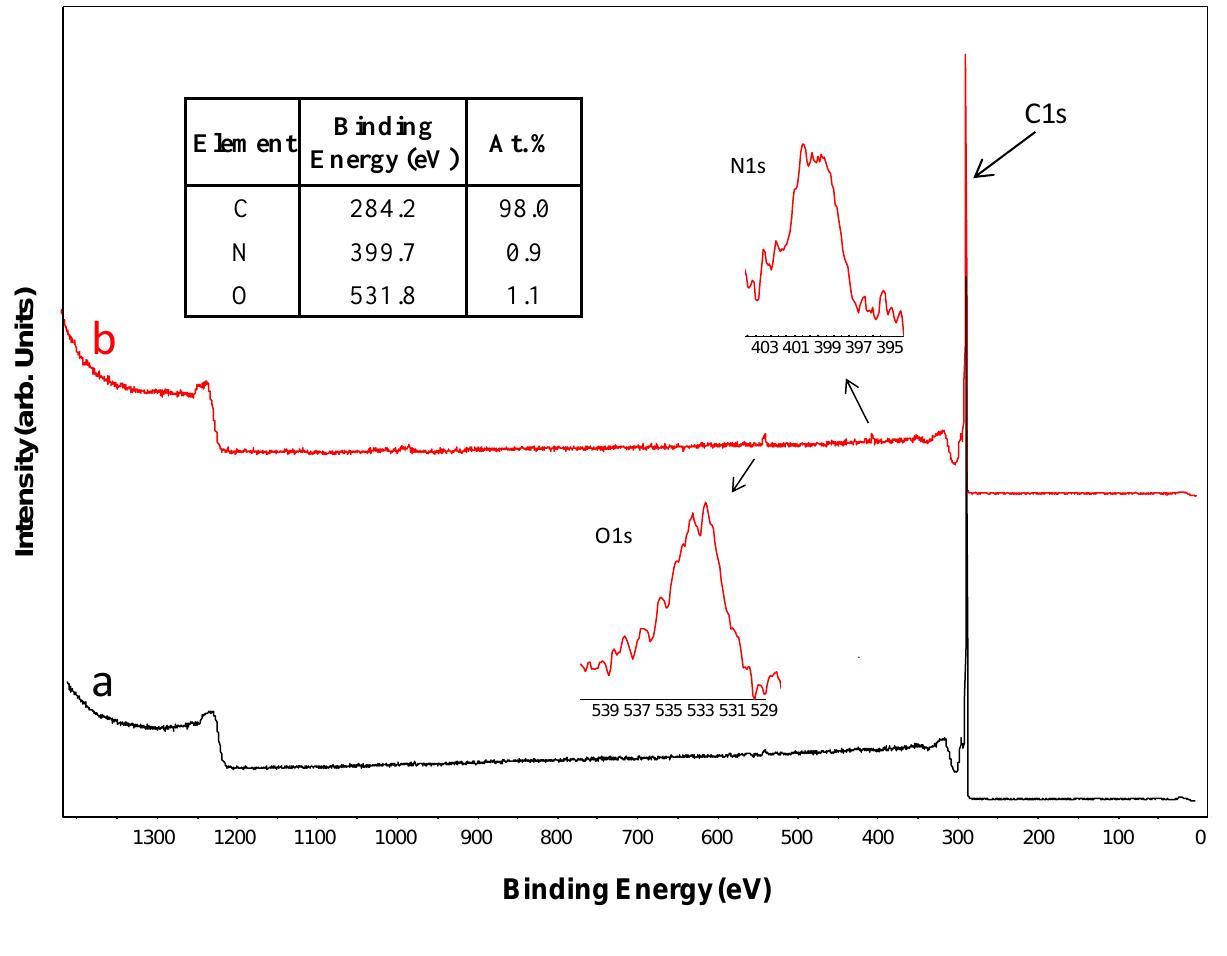
Figure 1. X-ray photoelectron spectroscopy (XPS) spectra of ( a ) pristine carbon nanotubes (CNTs) and ( b ) CNTs exposed to atomic nitrogen in the Ar + N post-discharge